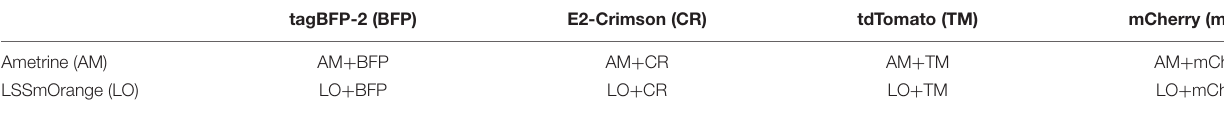
TABLE 1 | Fluorochrome combinations to distinguish between T cell lines that are